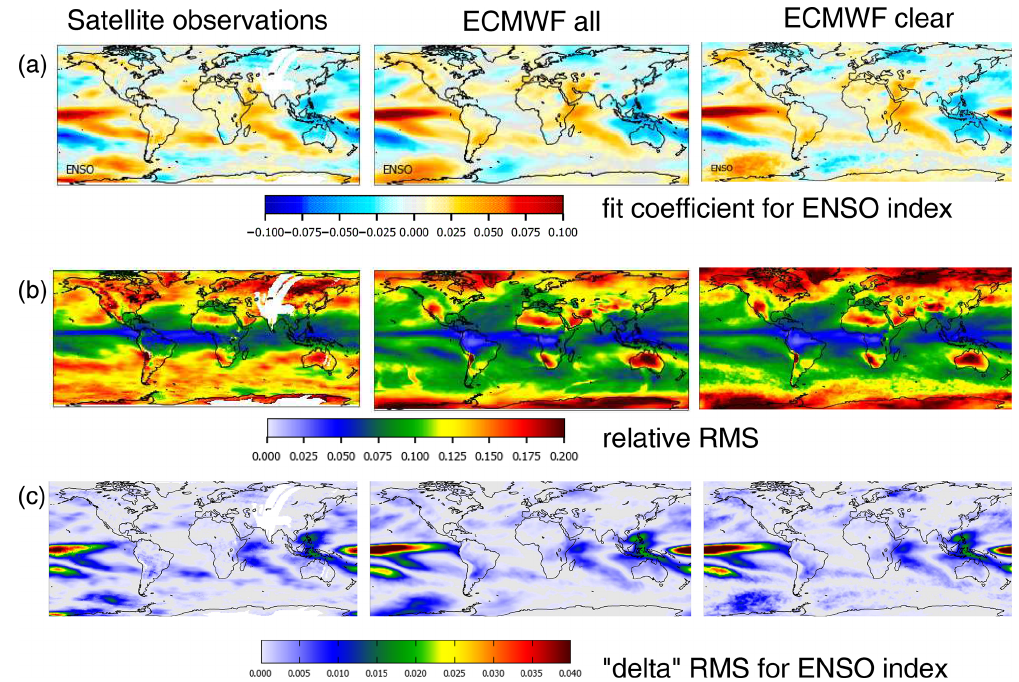
Figure 4. Global maps with the ENSO fit results for the three TCWV data sets. (a) Fit coefficients; (b) rms of the differences between original data sets and fit functions; (c) delta rms values which describe the relative difference of the rms if the ENSO index is included or excluded in the fit function (for details see